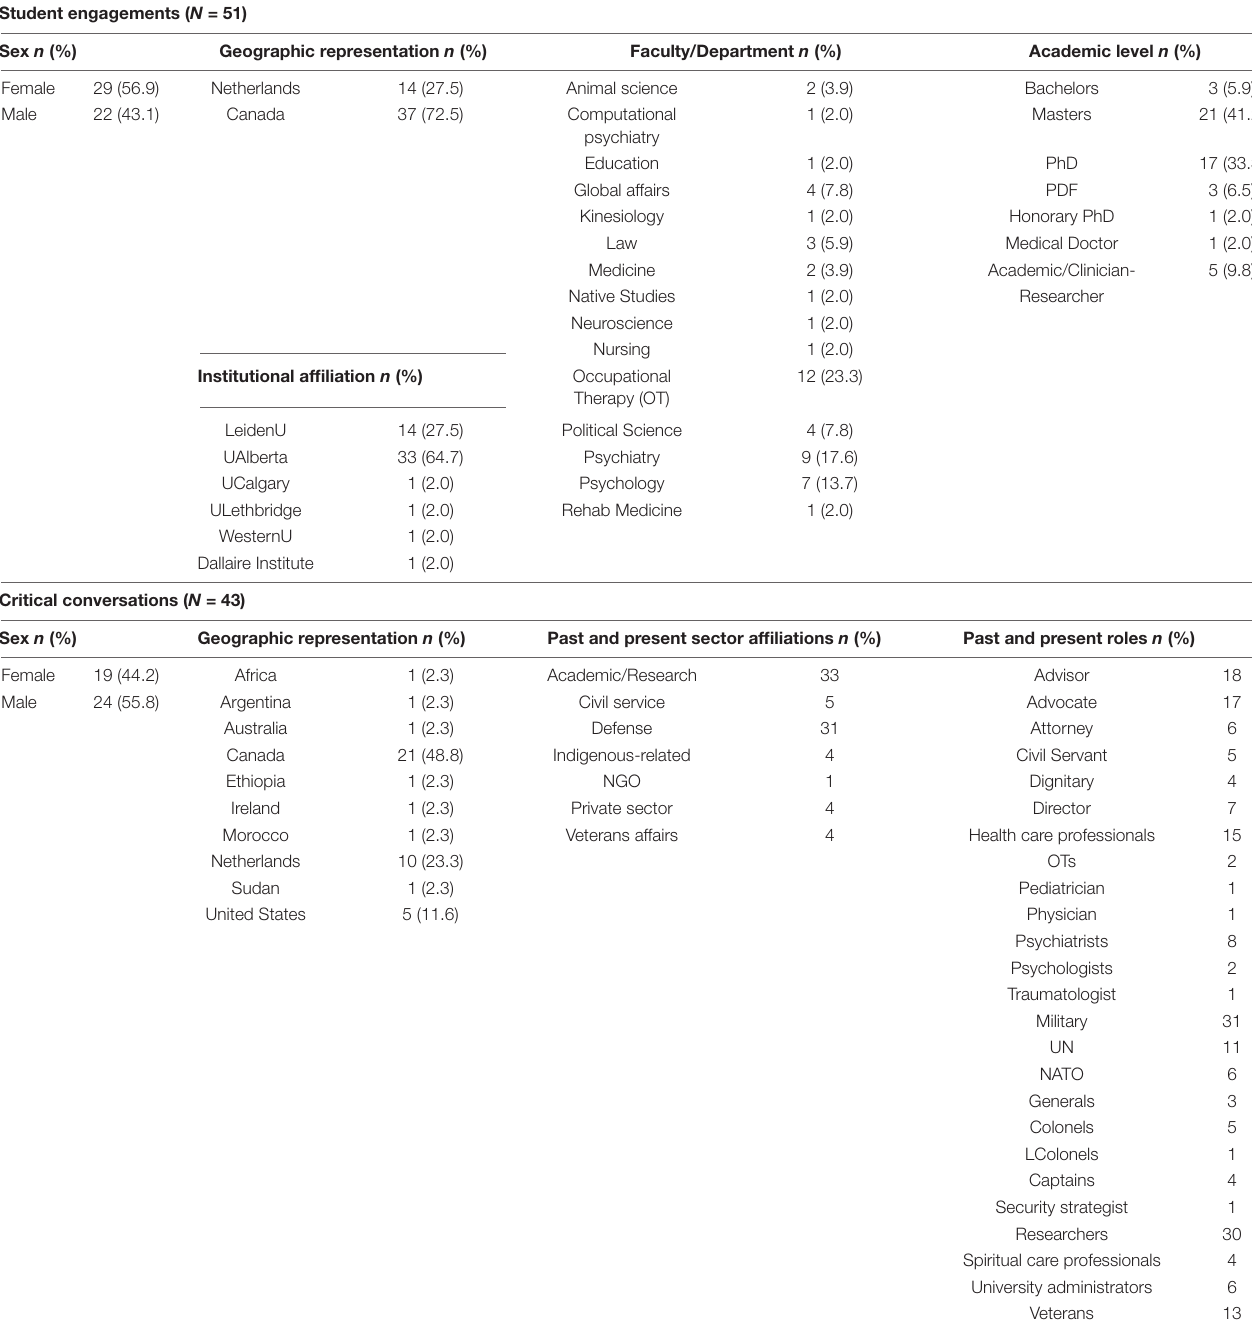
TABLE 1 | Participant demographics ( N = 94) for students engagements and conversations. Student engagements ( N =